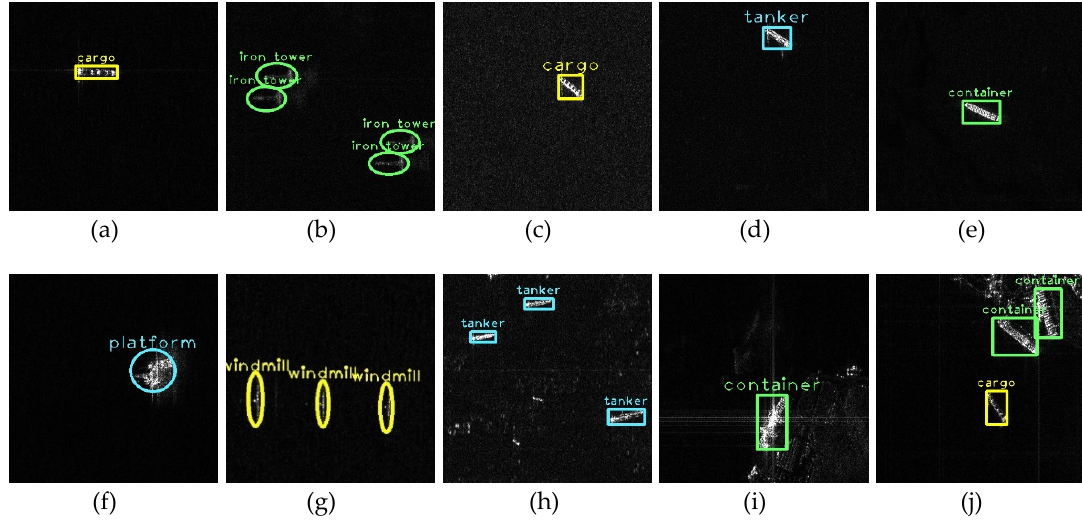
Figure 6. Detection results of the proposed MR-SSD. ( a ) Cargo; ( b ) tower; ( c ) cargo; ( d ) tanker; ( e ) container; ( f ) platform; ( g ) windmill; ( h ) tanker; ( i ) container; ( j ) cargo and container.